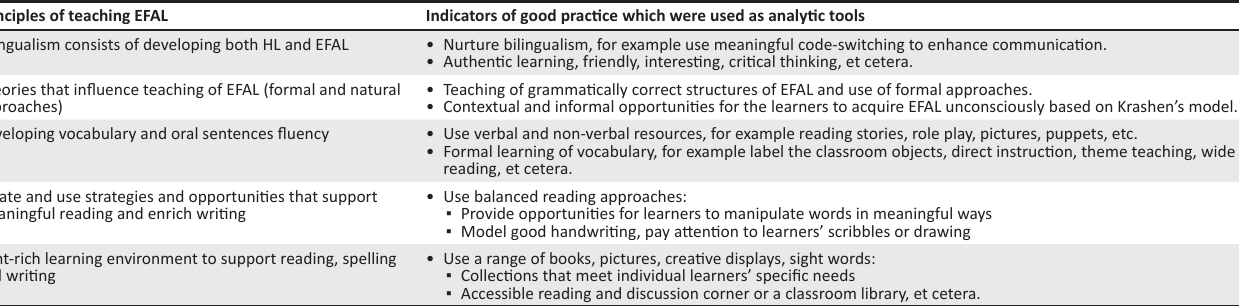
TABLE 1: Advanced Certificate in Teaching programme (English as First Additional Language) intended curriculum in relation to teaching English as First Additional Language at the Foundation Phase. Principles of teaching